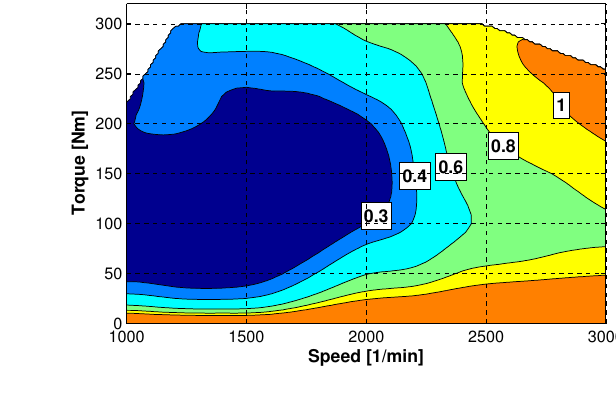
Figure 3. Experimental data for the fuel efficiency and the NO emissions of the diesel x engine. The torque is artificially limited at 300 N m, due to the test bench limitations, while the actual maximum torque is 540 N m. The data covers a speed range of 1000–3000 rpm; higher speeds are not considered. ( a ) Measured normalized fuel efficiency of the diesel engine; and ( b ) measured normalized NO emissions of the diesel engine ( g/kW h x g/kW h